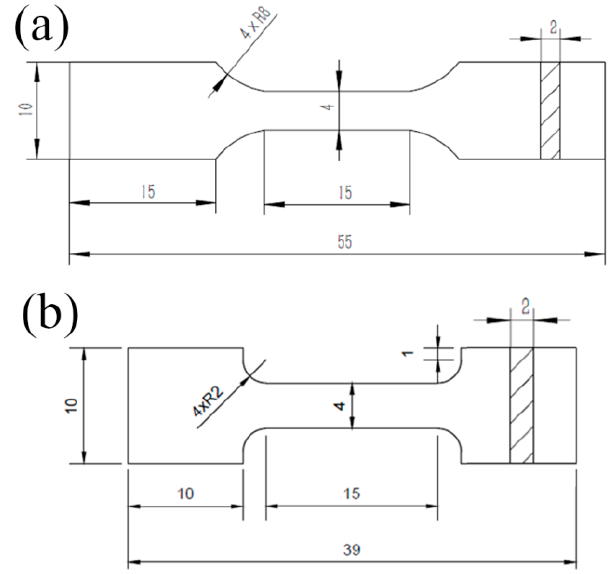
Figure 2. Dimensioned schematic of the room-temperature ( a ) and high-temperature ( b ) tensile specimens (unit: mm).